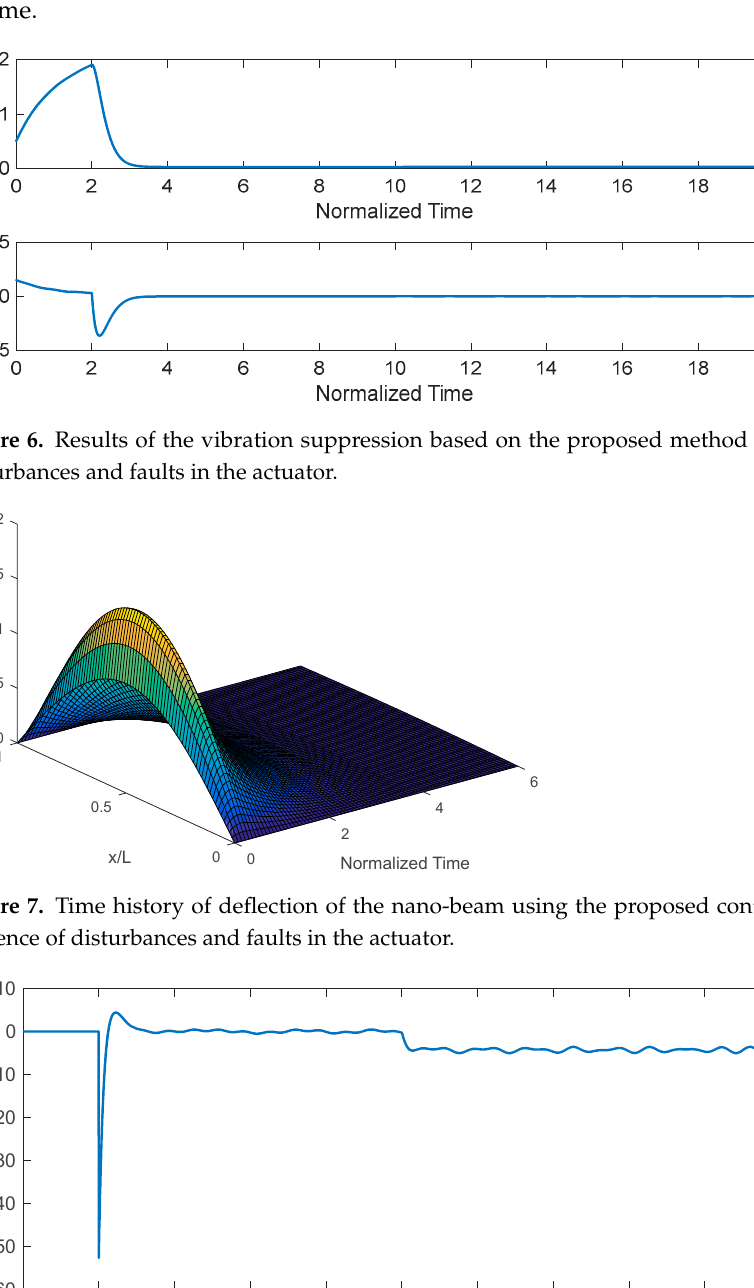
Figure 9. Results of the proposed finite time estimator in the presence of disturbances and faults in the actuator. In summary, the numerical simulations vividly illustrate the effectiveness of the pro- posed control scheme for stabilization of the nano-beam when there exist unexpected dis- turbances and faults. 5. Conclusions This study examined the stabilization of nonlinear vibrations in nano-beams using the non-local strain gradient theory. The equations of motion for the system were obtained and reduced to an ordinary differential equation using the Galerkin approach. A new dis- turbance-observer-based fault-tolerant terminal sliding mode control was then developed to stabilize the system, with a disturbance estimator included to handle uncertainties and faults in the control actuator. The stability of the closed-loop system was demonstrated using the Lyapunov stability theorem, and the performance of the proposed control scheme was compared to that of a PID controller through numerical simulations for two different cases. The results showed that the proposed control scheme was effective in sta- bilizing the uncertain nano-beam. It is acknowledged that terminal sliding mode control is known to have a singularity problem, where the control signal approaches infinity as the sliding surface approaches zero. This singularity problem is a well-known issue in the field of terminal sliding mode control and it is important to consider it. Therefore, it is suggested that some future studies in this field investigate and address the singularity problem in terminal sliding mode control for the control of nano-beams, such as the use